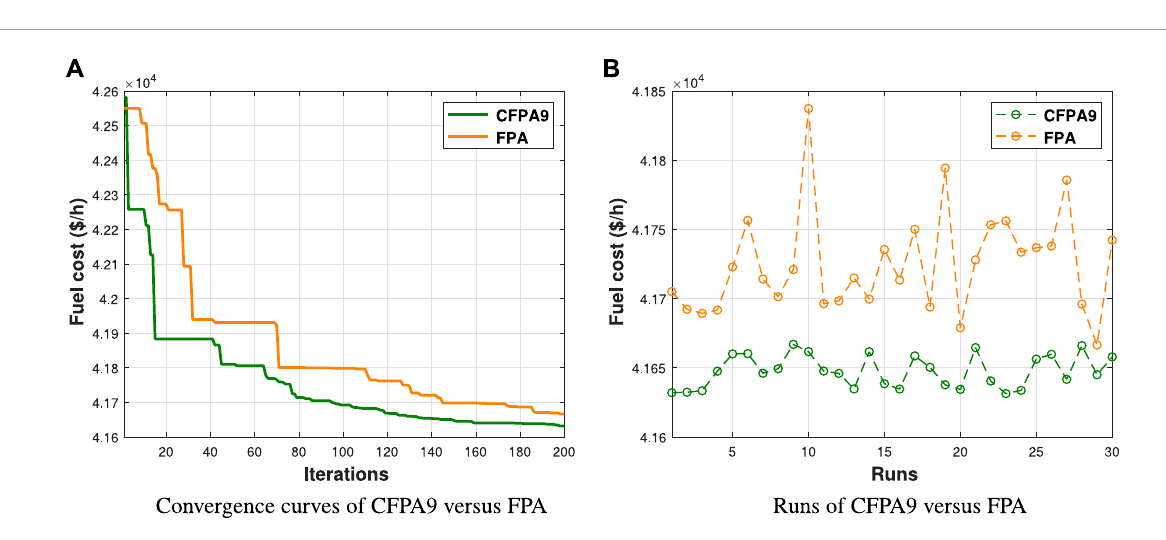
approaches are executed on a personal computer core i5 with a 4 GB-RAM Processor @ 1 . 8 GHz using MATLAB